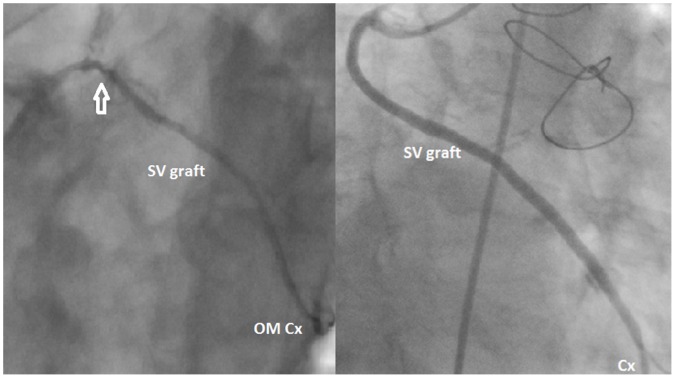
Follow-up coronary angiography.Fig. 1a. SVGD (⇑) in the graft implanted to the obtuse marginal branch of the circumflex artery in a 58-year old man admitted to a regional hospital due to unstable angina 27 months after surgery. The morphometric analysis of this SV segment obtained intraoperatively (see Figure 2a) revealed marked hypertrophy of the SV wall (WallTh 475.8 µm and WallAr 2.58 mm2) and its media (MedTh 329.2 µm and MedAr 1.43 mm2). The mean length/width index of the representative medial SMC nuclei was 5.7. Fig. 1b. Angiography of a normal SV aortocoronary bypass graft to the circumflex artery of a 75-year-old female patient without clinical symptoms of CAD deterioration performed 47 months after CABG. The results of the morphometric study (see Figure 2b) were as follows: WallTh 329.2µm, WallAr 1.55 mm2, MedTh 199.8 µm, MedAr 0.60 mm2. The SMC nuclei were spindle-shaped with a mean length/width index of 10.1. Abbreviations: Cx – circumflex artery; OMCx – obtuse marginal branch of the circumflex artery; SVgraft – saphenous vein bypass graft.